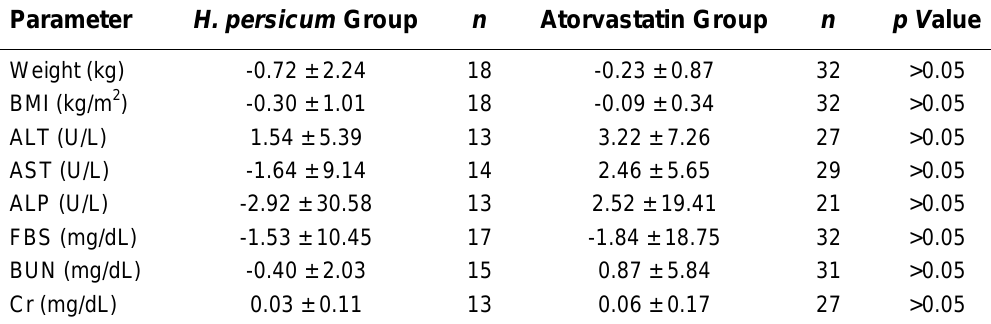
Atorvastatin Groups